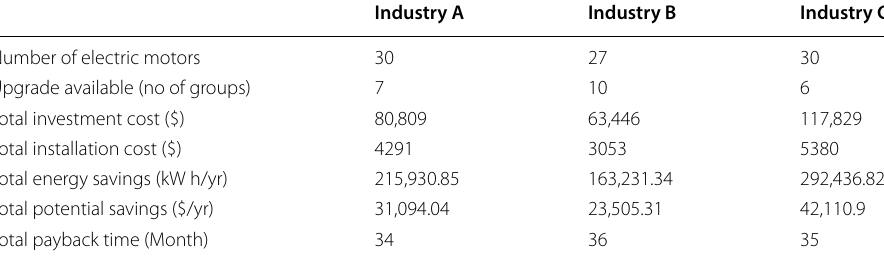
Table 6 Overall investment and saving on electric motor